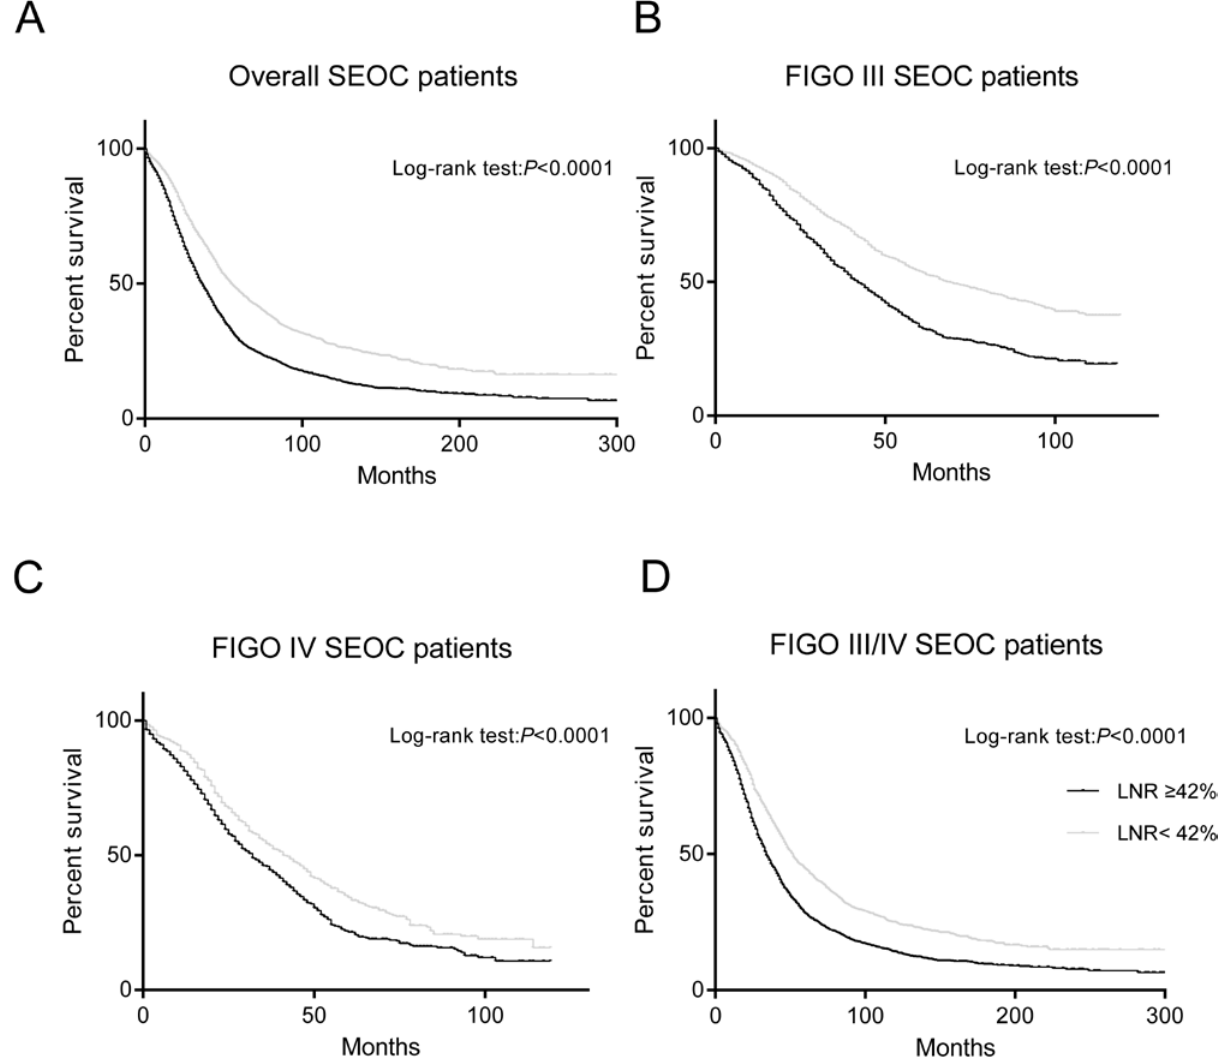
Figure 1. Kaplan-Meier curve for patients with LNR<42.0% and LNR≥42.0%. nodal-positive patients (A), stage-III patients (B), stage-IV patients (C) and stage III/IV patients (D), respectively. OS of patients with LNR≥42.0% was significantly shorter than that of those with LNR<42.0% (P < 0.0001, log-rank